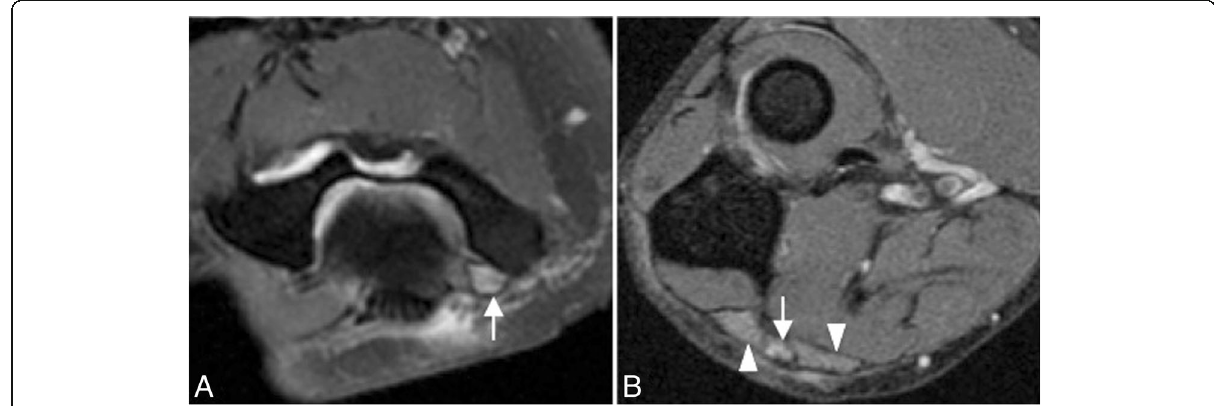
Fig. 11 A 60-year-old woman with pain, muscle weakness, and paresthesias. Axial FS PD-weighted MRI ( a , b ) showing an enlargement and hyperintense ulnar nerve in the cubital tunnel (white arrow) and subacute denervation of the flexor carpi ulnaris muscle (white